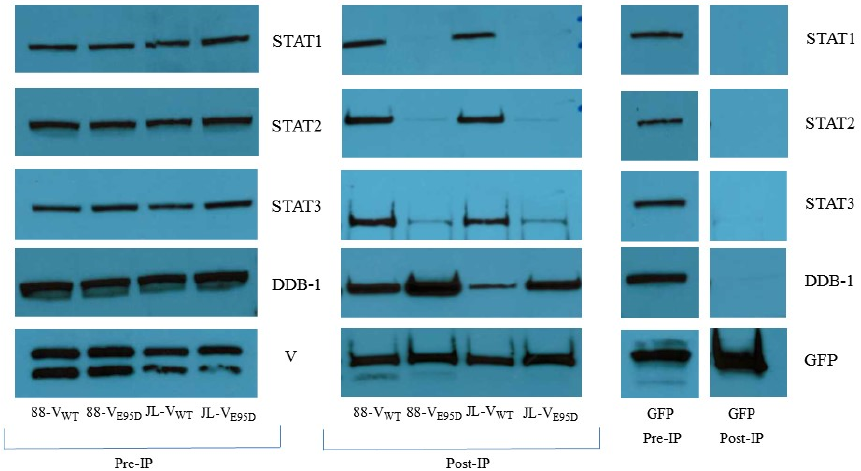
Figure 5. Association of the MuV V protein variants with cellular proteins. Confluent monolayers of 293-A cells were transfected with FLAG-tagged V or FLAG-tagged GFP expressing constructs and harvested 48 h post-transfection. The cells were processed for affinity purification with a fraction reserved for direct lysis in sample buffer (pre-IP). Protein complexes bound to the anti-FLAG agarose beads were eluted in sample buffer (post-IP). Samples were resolved by SDS-PAGE followed by western blotting. The blots were probed with anti-STAT1, anti-STAT2, anti-STAT3, anti-DDB-1, anti-GFP and anti-mumps P / V antibodies. Note, this blot is representative of three independent experimental repeats. While the 88-1961 and JL derived V E95D proteins coprecipitated STAT1, 2 and 3 extremely weakly (faint bands were consistently present for the three proteins in each repeat experiment) compared to V WT , increased coprecipitation of DDB1 was observed relative to the wild type V counterpart. The pre-IP blot in each case demonstrates equal amounts of lysates were used for the pulldown, and the FLAG-Tagged GFP pulldown demonstrates the specificity of the